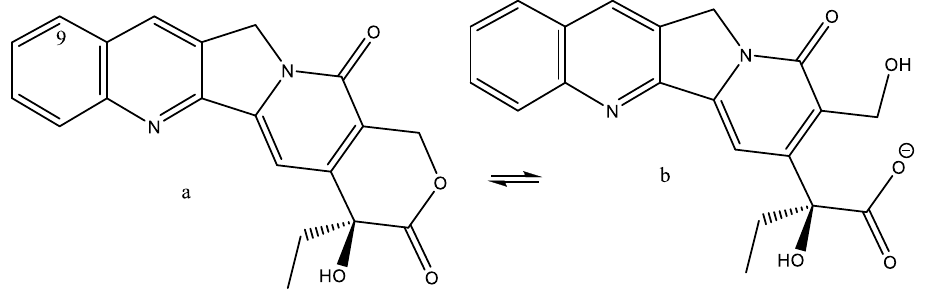
Figure 7. Closed and open forms of camptothecin.